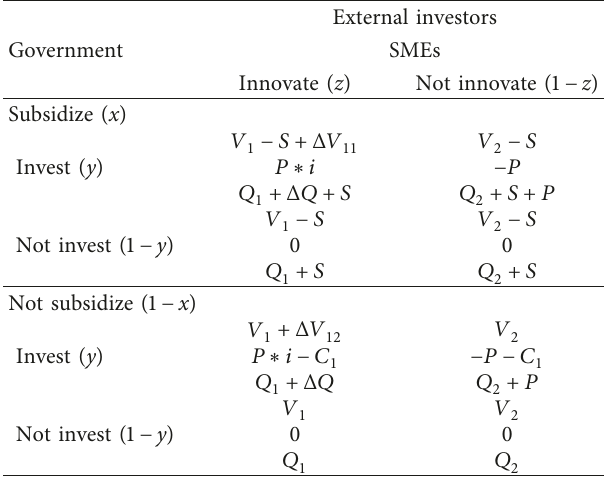
Table 2: The payoff matrix among the government, investors, and